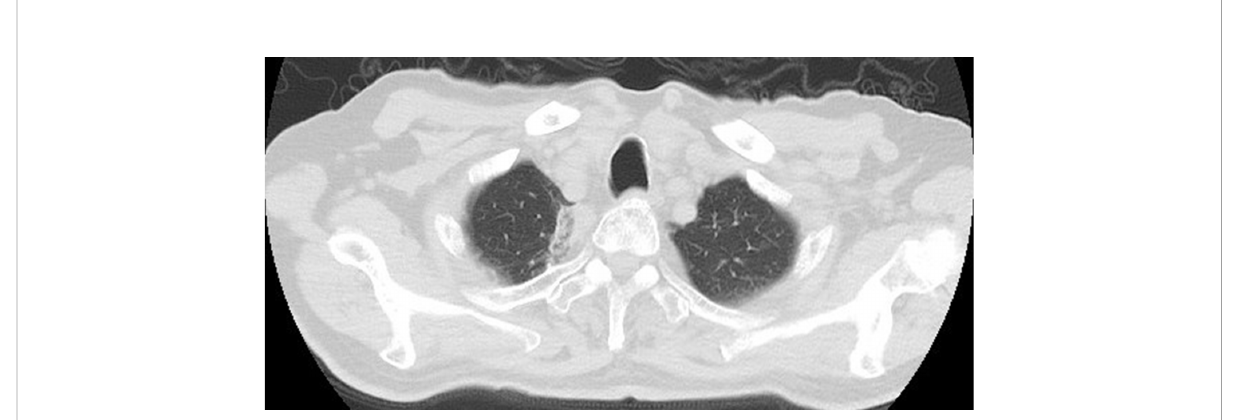
FIGURE 11 Cross-sectional image:Follow-up after 1 month found that the lesions were completely ablated, and no tumor lesions remained or